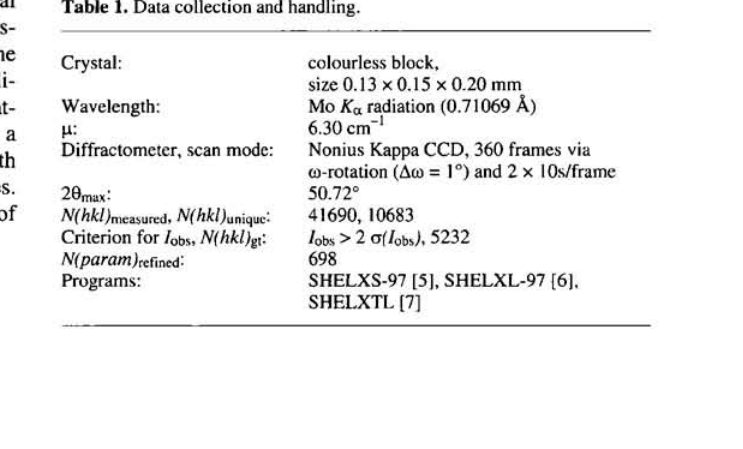
Table 1. Data collection and